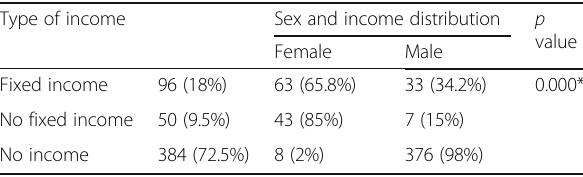
Table 4 Income distribution among males and females